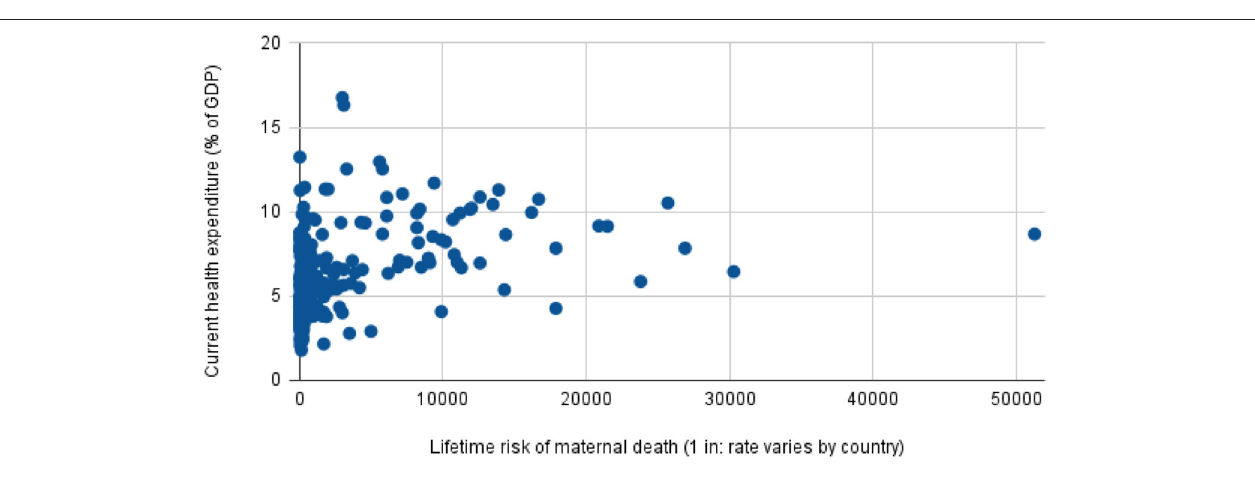
FIGURE 5 | Current health expenditure (% of GDP), by Lifetime risk of maternal death (1 in: rate varies by country) Source: World Bank Data:Current health expenditure (% of GDP), Trends in Maternal